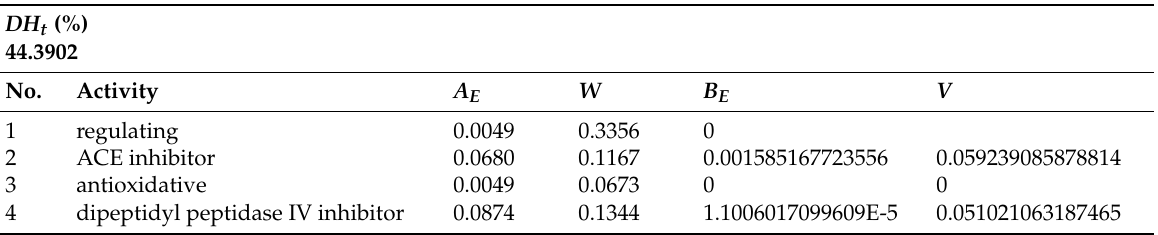
Table A30. A E , DH t , W , B E and V values from RubisCO of Halophila stipulacea . In silico enzymatic cleavage was carried out by using ficin.